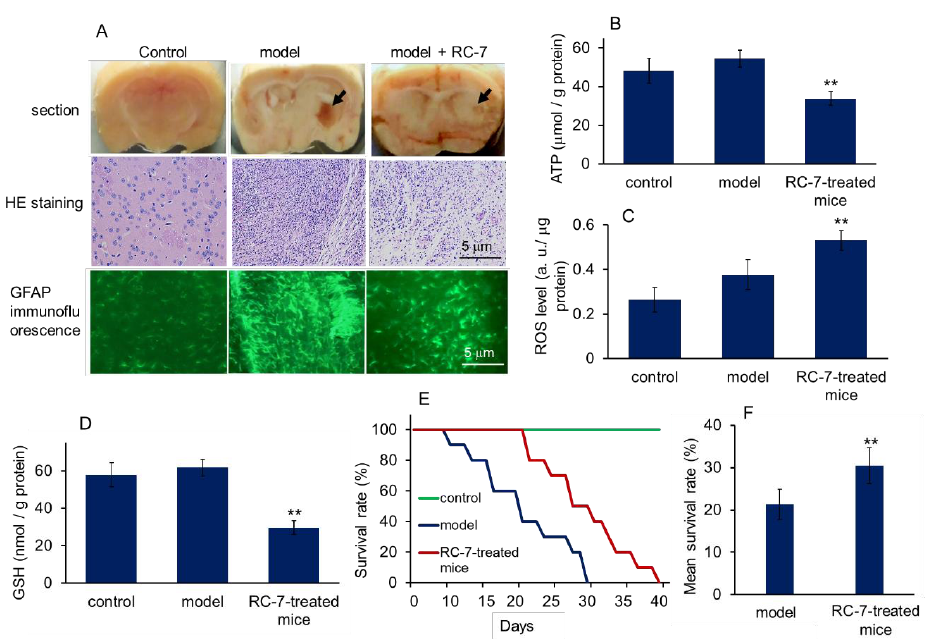
Figure 8. Antitumor effect of RC-7 on glioma-bearing mice. ( A ) Glioma mass in striatum. Obvious glioma mass appeared about 3 weeks after U251MG cell microinjection. The arrows indicated the glioma mass. Representative images of HE staining and GFAP immunofluorescence in mouse brain sections (400 × ) from mice microinjected with saline and treated with saline (control), mice microinjected with U251MG and treated with saline (model), and mice microinjected with U251MG cells and treated with 10 mg / kg concentration of RC-7 daily at 12 days post-microinjection and 7 days post-treatment. ( B ) ATP content, ( C ) ROS, and ( D ) GSH levels in microinjection region. ( E ) Survival curve and ( F ) mean survival days of the tumor-bearing mice untreated or treated with RC-7 ( n = 10 for each group). ** p < 0.01 compared with the model mice.